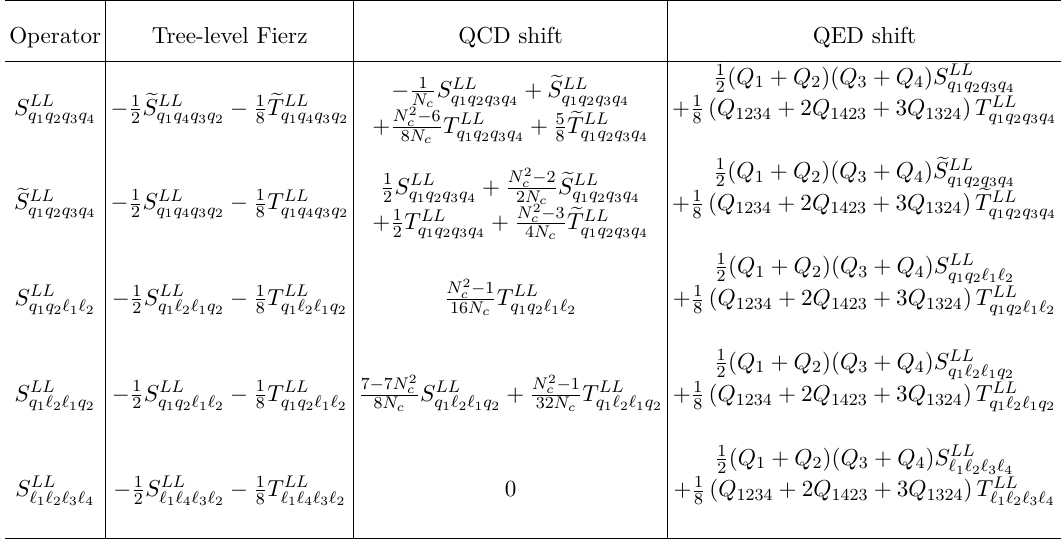
Table 5. Fierz transformations for scalar P L ⊗ P L operators together with their one-loop QCD and QED shifts in the original BMU